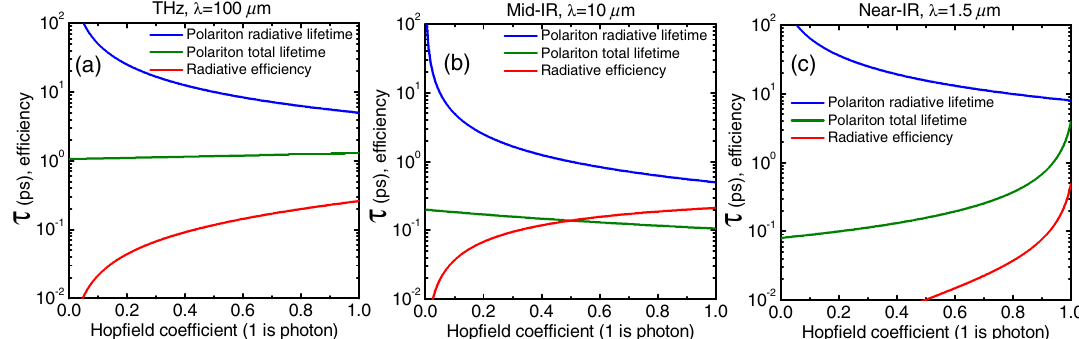
FIG. 3. Polariton radiative lifetime (solid blue lines), polariton total lifetime (solid green lines), and radiative efficiency (solid red lines) as a function of the lower polariton-state Hopfield coefficient. A value of 1 represents a full photonic component. (a) THz range, (b) mid-IR range, and (c) near-IR